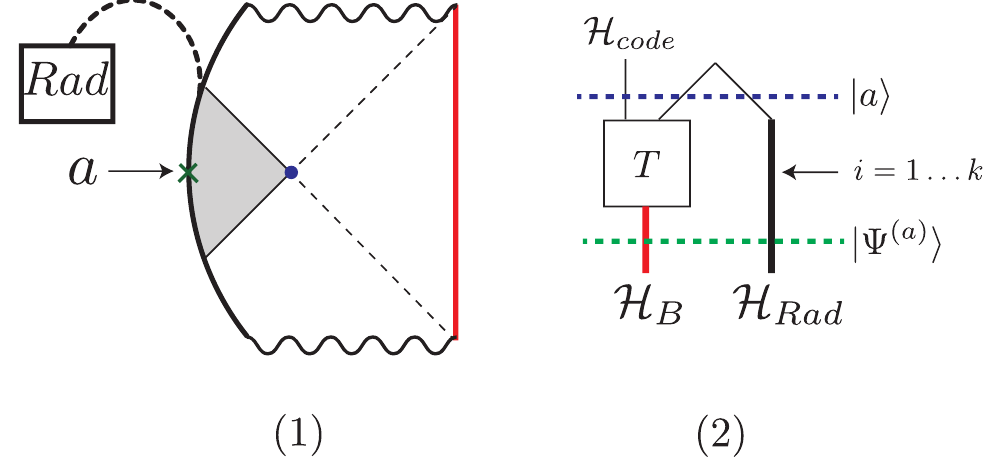
(cid:12) (cid:11) in the code subspace we consider in Figure 2 . (1) The Lorentzian description of a state (cid:12) Ψ ( a ) the PSSY Model, a JT gravity black hole with an ETW brane. The ETW brane carries frozen flavor indices that are entangled (dashed black line) with radiation system Rad . They also carry fluctuating flavor indices, denoted a , that can be arbitrarily specified. The extremal surface is denoted in purple and the island that dominates for sufficiently large k is coloured gray. (2) A tensor network description of the states in the code subspace. The boundary state (cid:12) (cid:12) Ψ ( a ) (cid:11) is defined in terms of cut of a tensor network (dashed green line). The tensor T represents the encoding map defined by eq. (2.7). The semiclassical state | a i is defined by a different cut of the tensor network (dashed blue line). The network represents an approximate isometry from H to H code B ⊗ H Rad